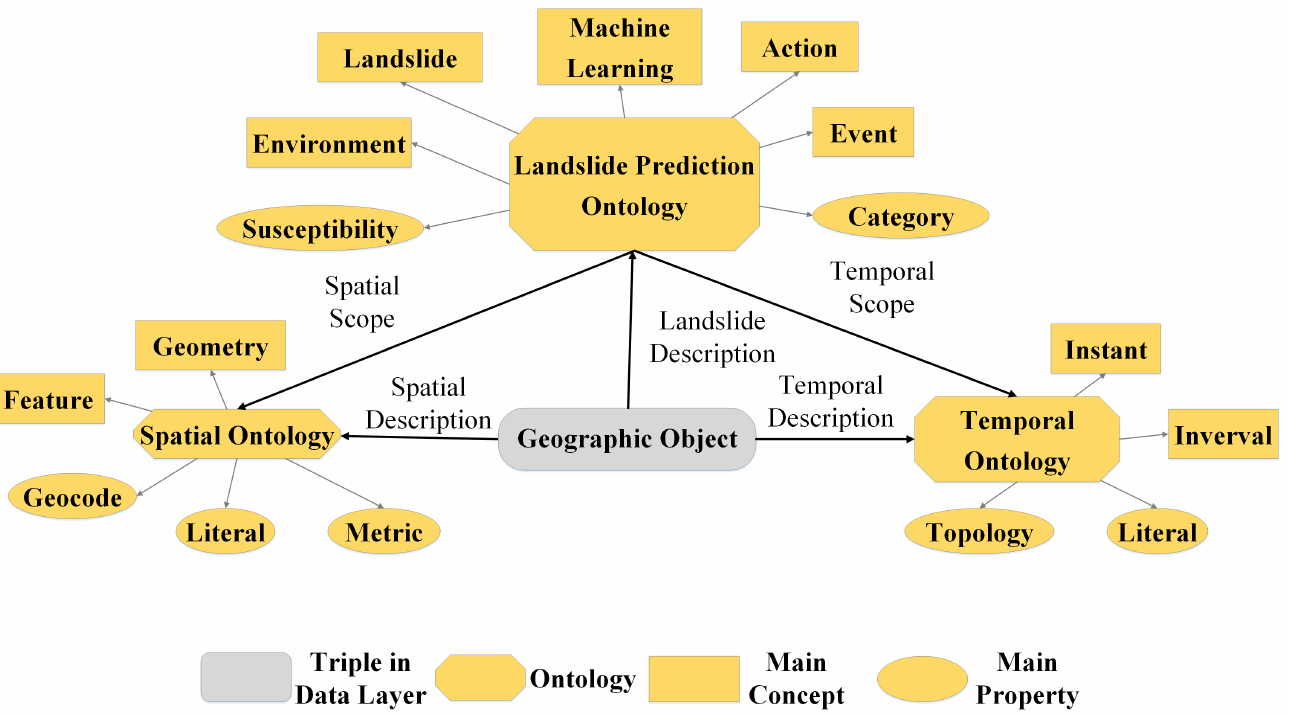
Figure 3. Schema structure, including the division of ontology, main concepts and